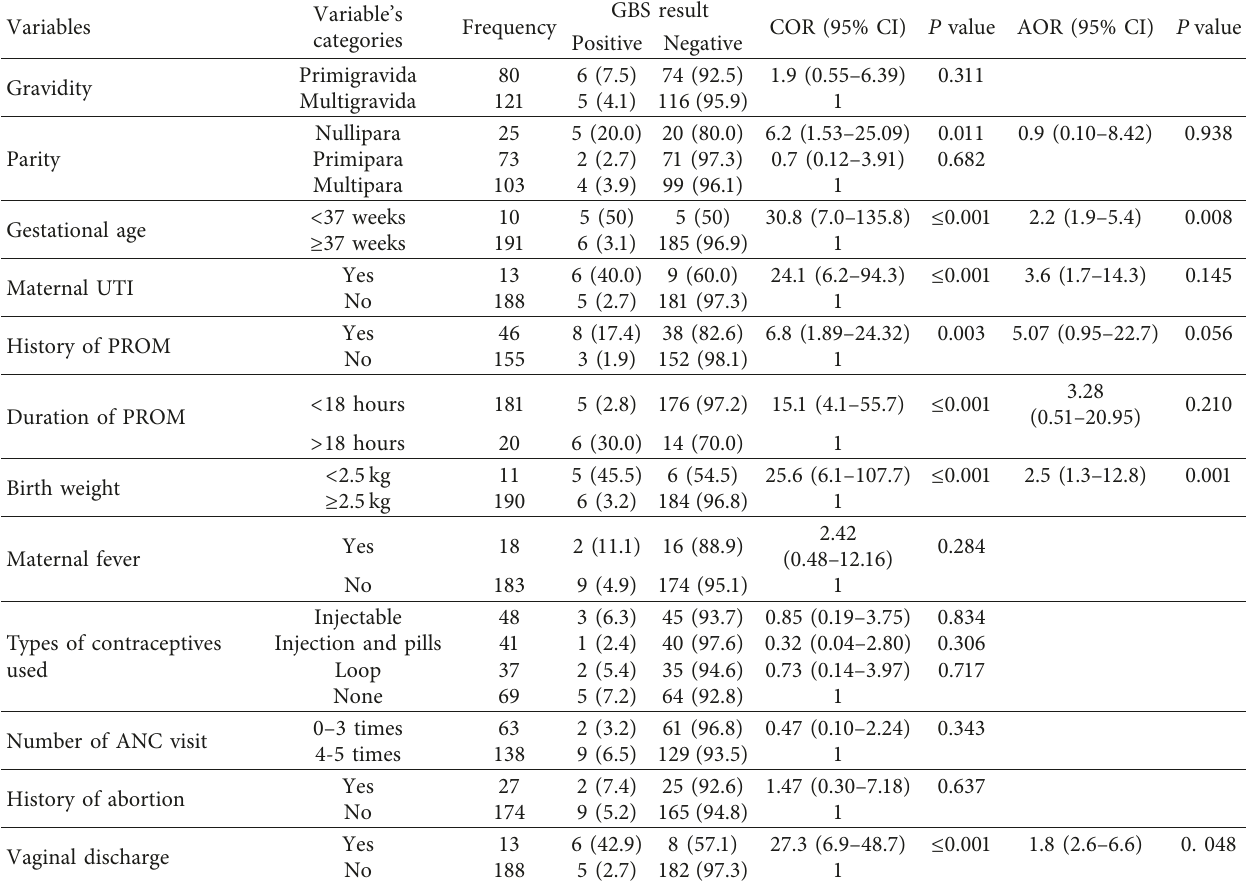
Table 4: Multivariate analysis of clinical factors with GBS colonization (vertical transmission) among neonates.